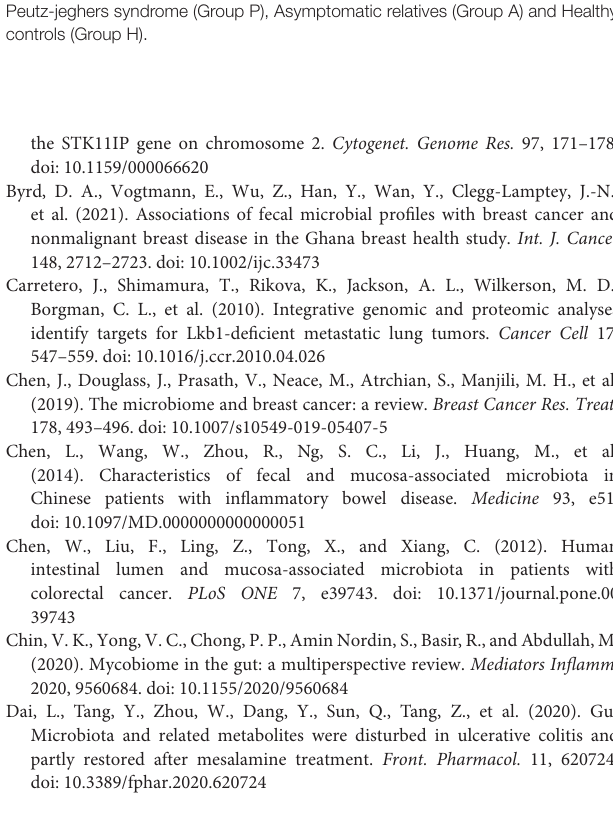
Supplementary Figure 1 | Histograms of the different levels of bacteria. (A) Histograms on the class level. (B) Histograms on the order level. (C) Histograms on the family level. (D) Histograms on the genus level. (E) Histograms on the species level. Supplementary Figure 2 | Composition of fungi at different levels. (A) Composition of fungi at the class level. (B) Composition of fungi at the order level. (C) Composition of fungi at the family level. (D) Composition of fungi at the genus level. (E) Composition of fungi at the species level. Supplementary Figure 3 | Heatmap of module based on PICRUSt 2. Differences among patients with Peutz–Jeghers syndrome patients (Group P), asymptomatic relatives (Group A), and healthy controls (Group H). Supplementary Figure 4 | Variations in the composition of fungal functional groups inferred by FUNGuild. Differences in fungal functional groups among patients with Peutz–Jeghers syndrome (Group P), asymptomatic relatives (Group A), and healthy controls (Group H). Supplementary Table 1 | Indicators of α -diversity in bacteria. Peutz-jeghers syndrome (Group P), Asymptomatic relatives (Group A) and Healthy controls (Group H). Supplementary Table 2 | Indicators of α -diversity in fungal mycobiome. Peutz-jeghers syndrome (Group P), Asymptomatic relatives (Group A) and Healthy controls (Group